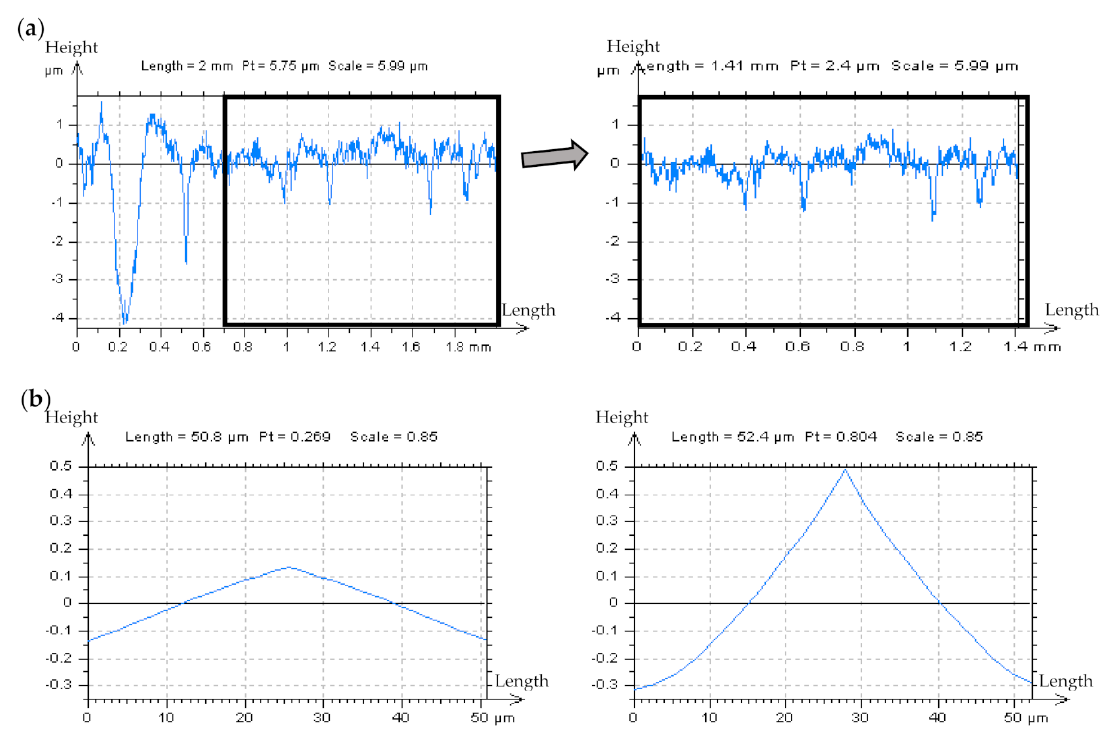
Figure 6. The profiles ( a ) and their respective centre–parts of the ACFs graphs ( b ), extracted from the plateau–honed cylinder liner surface texture with additionally burnished dimples, measured with the stylus technique at a speed of 0.5